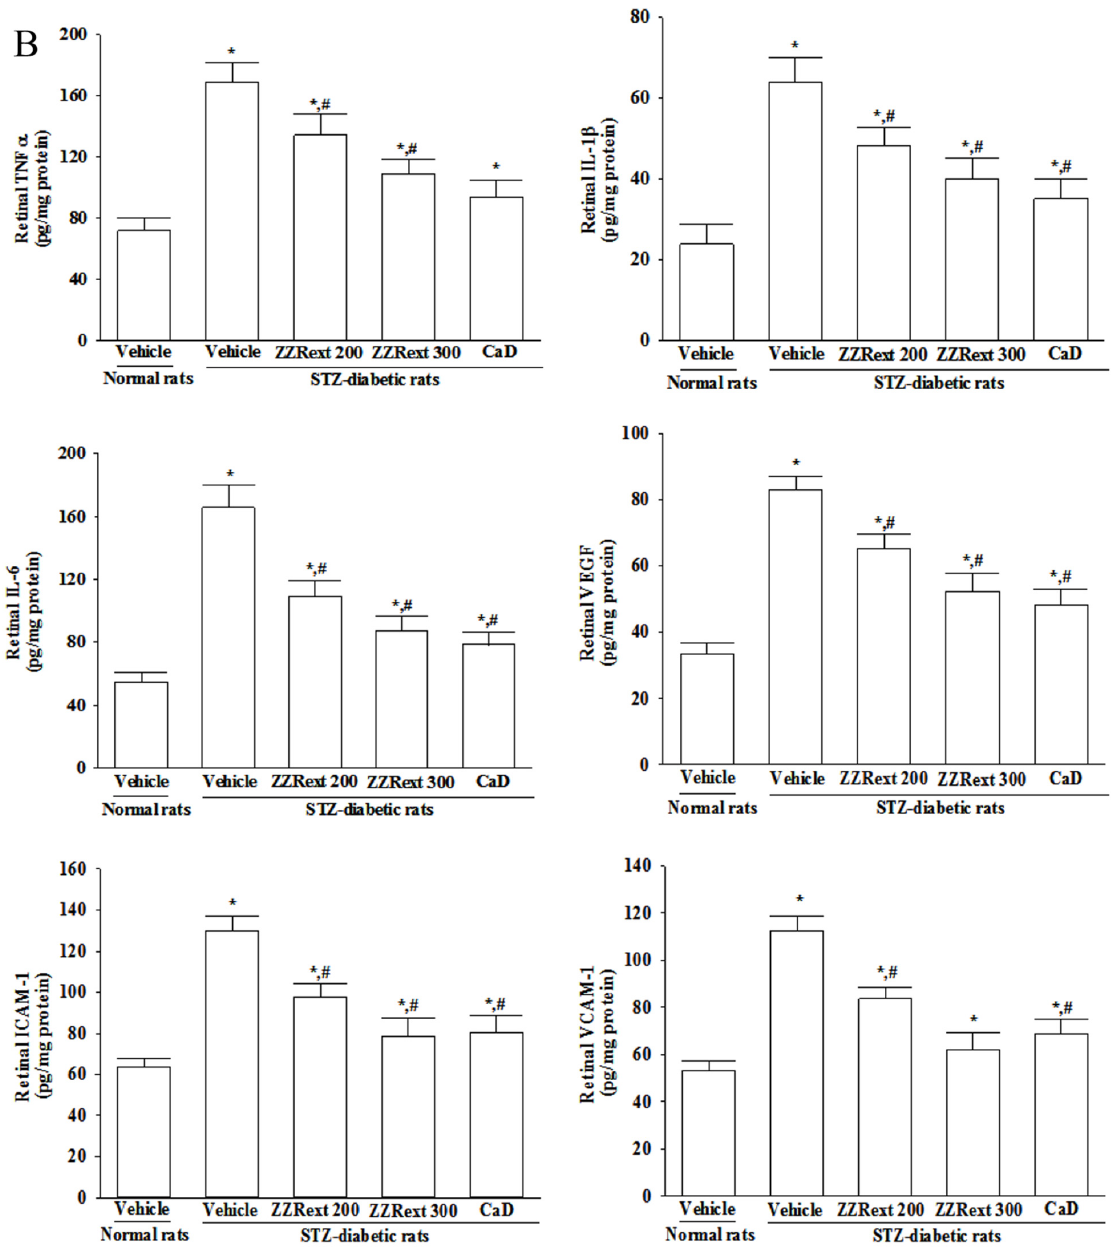
Figure 3. Effects of the treatments on the ( A ) mRNA and ( B ) protein levels of inflammatory cytokines and adhesion molecules in retina of rats. STZ-diabetic rats were administered 200 mg/kg/day ZZRext (ZZRext 200), 300 mg/kg/day ZZRext (ZZRext 300) or 500 mg/kg calcium dobesilate (CaD) by oral gavage once daily for three months. Another group of STZ-diabetic rats and normal rats were administered the same volume of vehicle. Data are mean ± S.D. (Standard Deviation) from eight rats per group, and the experiments were repeated independently at least three times with similar results. * p < 0.05 compared to the values of vehicle-treated normal rats. # p < 0.05 compared to the values of vehicle-treated STZ-diabetic rats.